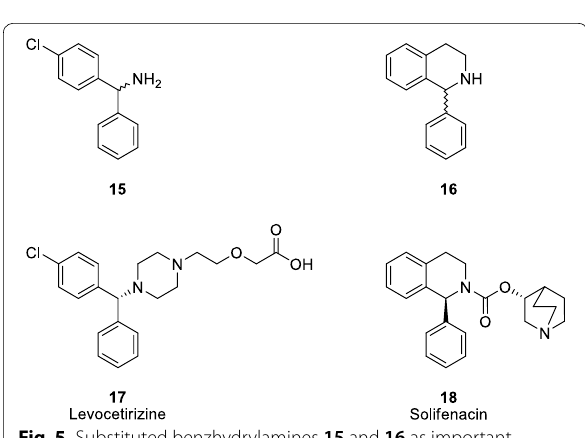
Fig. 5 Substituted benzhydrylamines 15 and 16 as important structural motifs in commercial pharmaceuticals Levocetirizine 17 and Solifenacin 18 ,